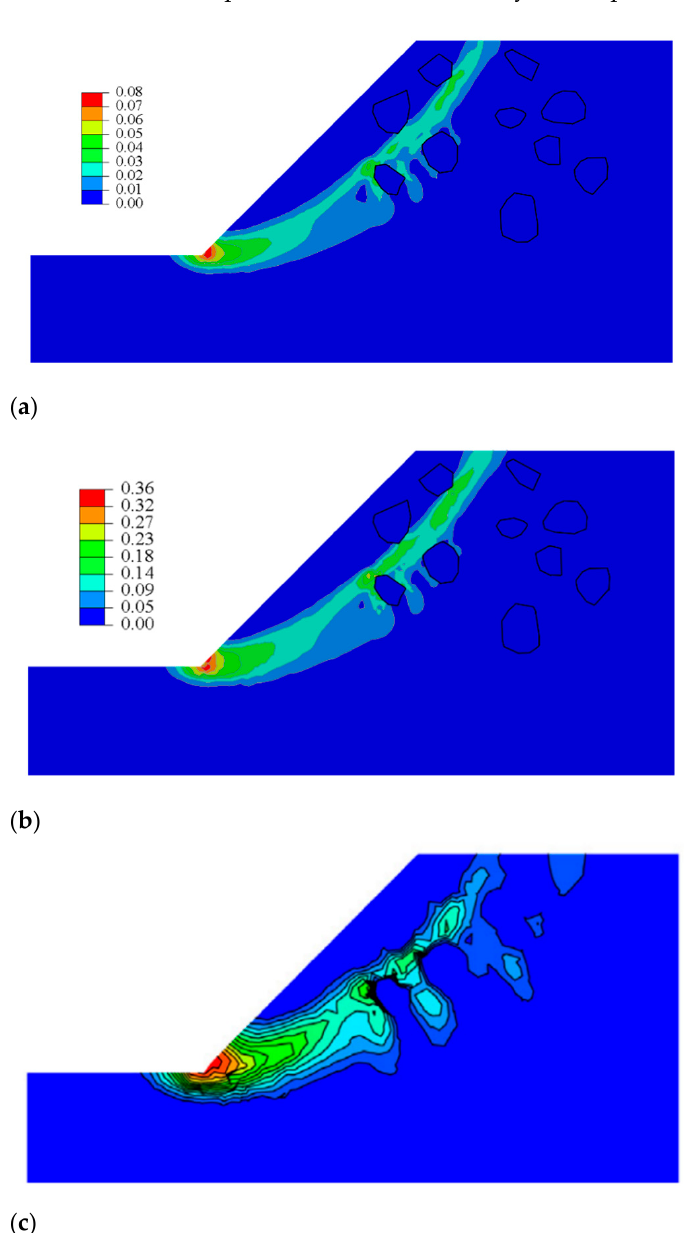
Figure 17. The contours of equivalent plastic strain by the SRM for Example 3. ( a ) F i = 0.95. ( b ) F i = 1.09. ( c ) F i = 1.07 [12].